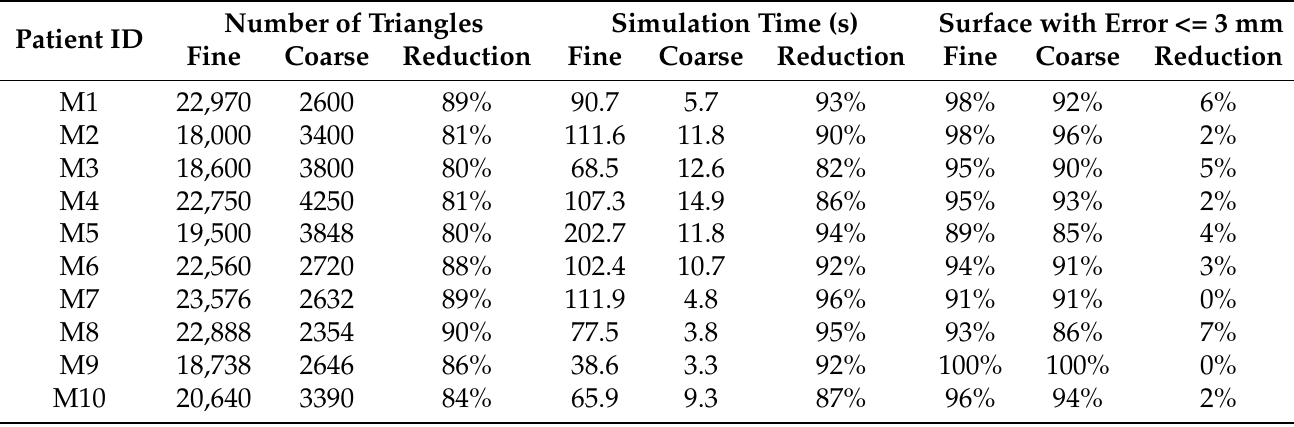
Table 4. Summary of simulation results for all patients. The table compares simulation time and error for fine and coarse